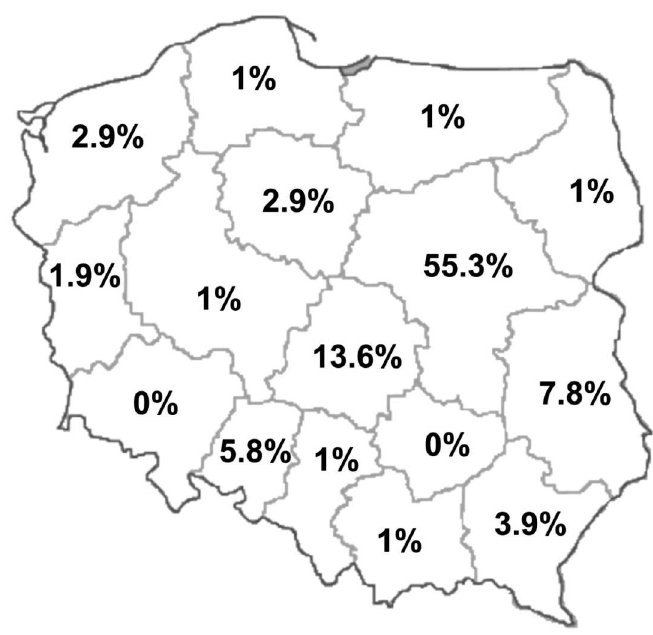
Figure 3. Distribution of the number of the surveyed paramedics according to the place of